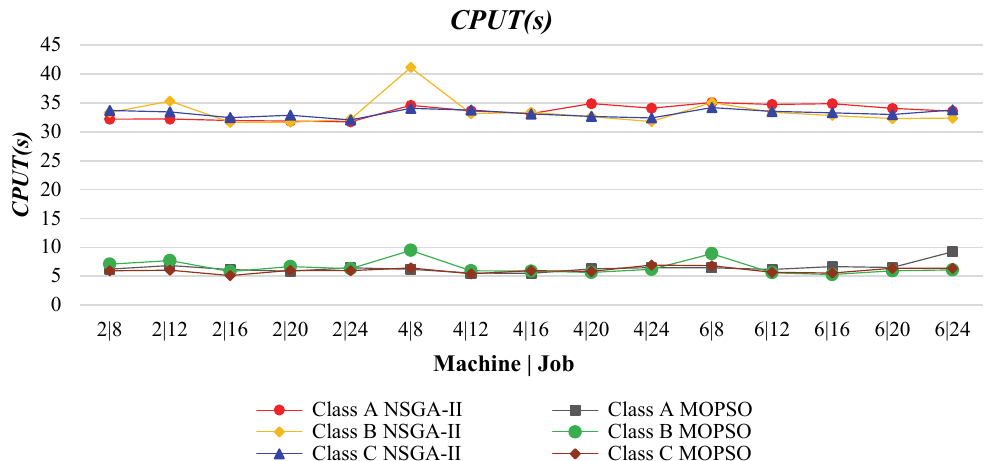
Fig. 14. CPUT criterion for the two algorithms in the small scale sample